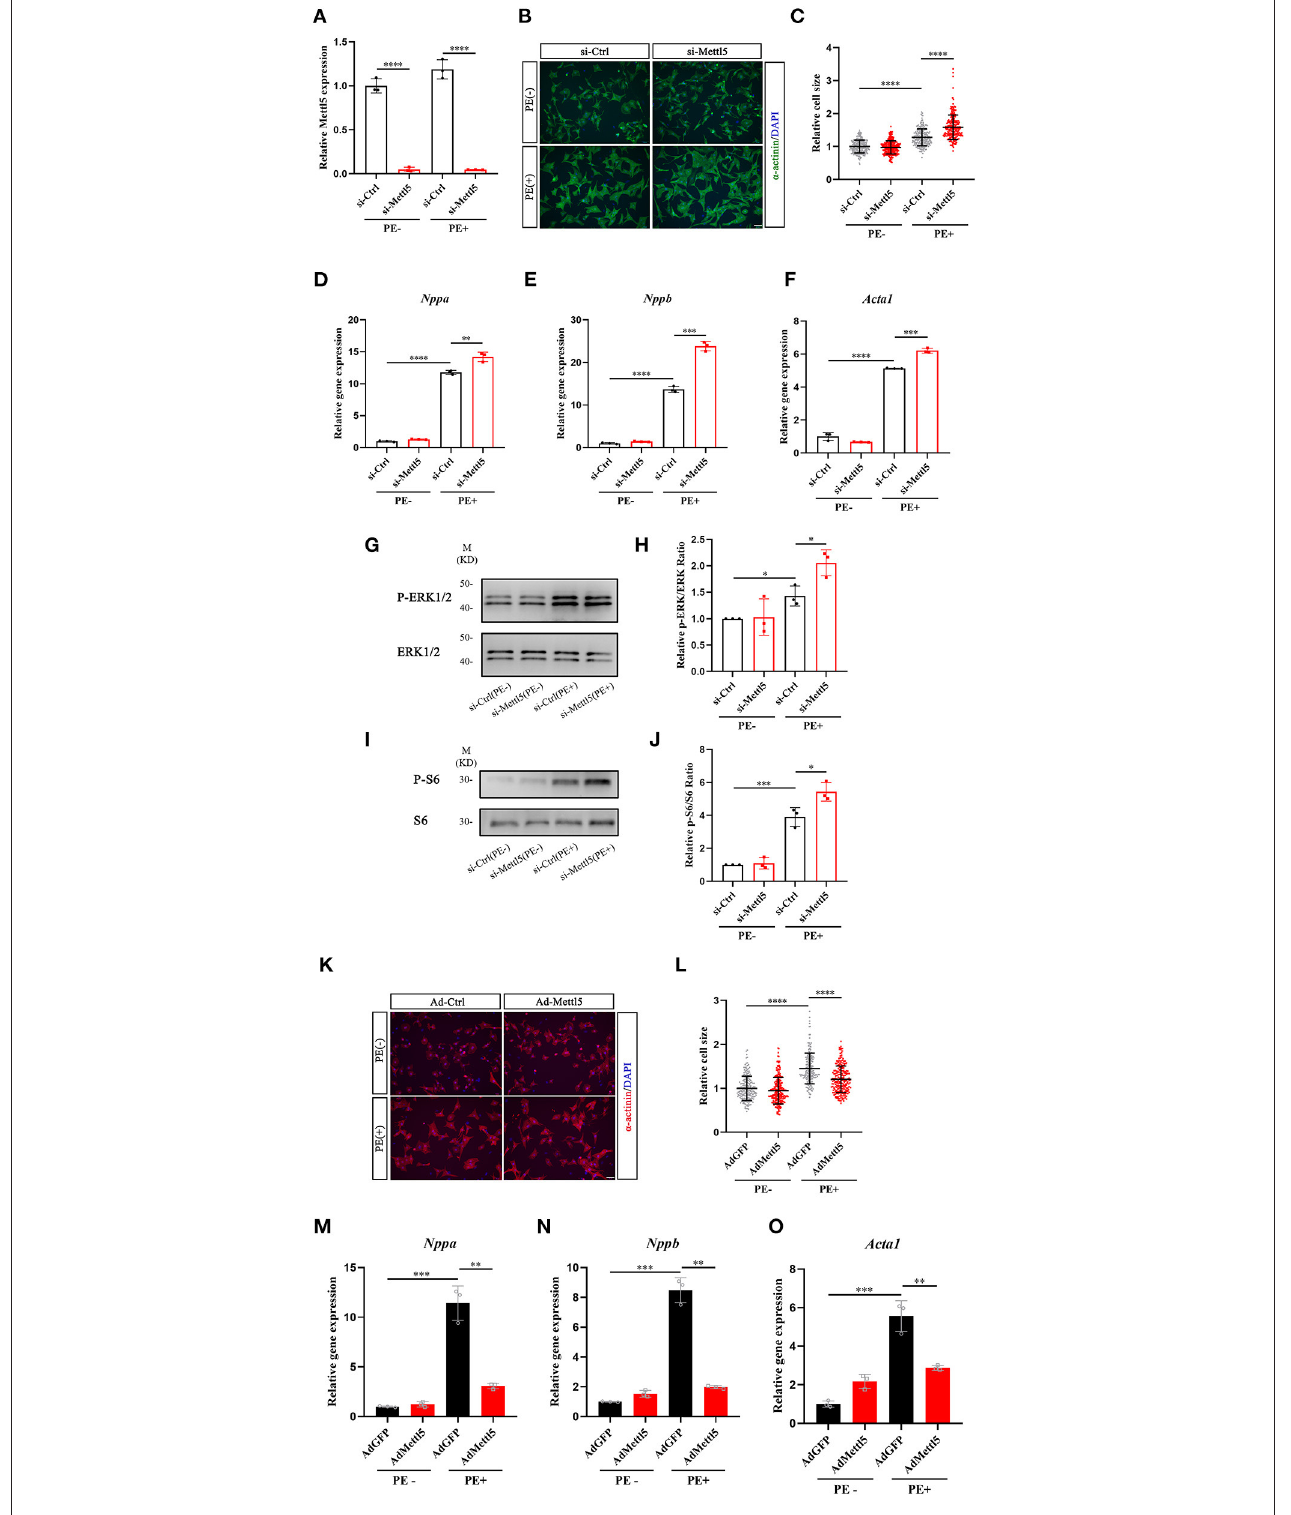
FIGURE 3 | METTL5 promotes hypertrophic growth of cardiomyocytes in vitro. (A) qRT-PCR detecting the knockdown of METTL5 in neonatal rat ventricular cardiomyocytes (NRVMs) with siRNA. n = 3 in each group. (B) Representative images of immunostaining of NRVMs transfected with si-METTL5 or control